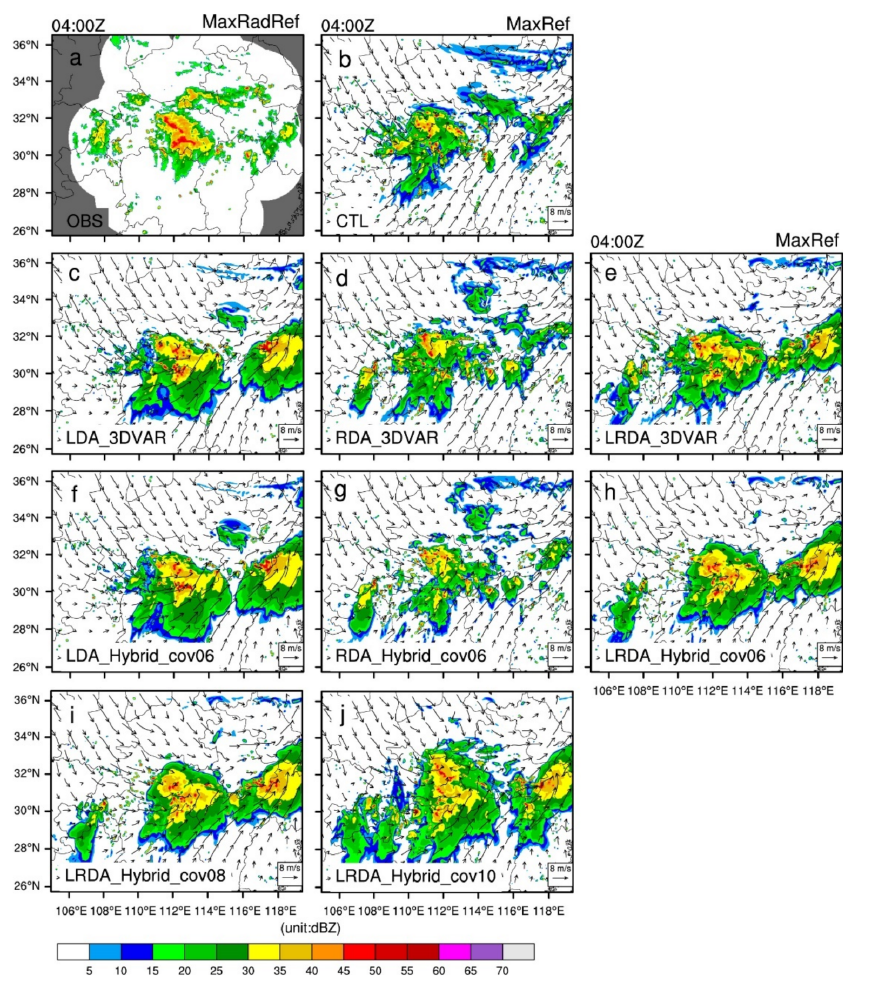
Figure 10. As in Figure 7, but for the cycling analysis experiments at 0400 UTC on 30 June 2018 (i.e., 3 h forecast). ( a ) Observed maximum radar reflectivity interpolated onto the 3 km simulation domain (OBS), ( b ) control run (CTL), lightning ( c , f ), radar ( d , g ) and the combined lightning and radar data assimilation ( e , h ) by 3DVAR ( c – e ) and hybrid 3DEnVAR ( f – h ) showed that β 1 = 0.4, β 2 = 0.6. The combined lightning and radar data assimilation by hybrid 3DEnVAR ( i , j ) showed that β 1 = 0.2, β 2 = 0.8 and β 1 = 0.0, β 2 = 1.0,